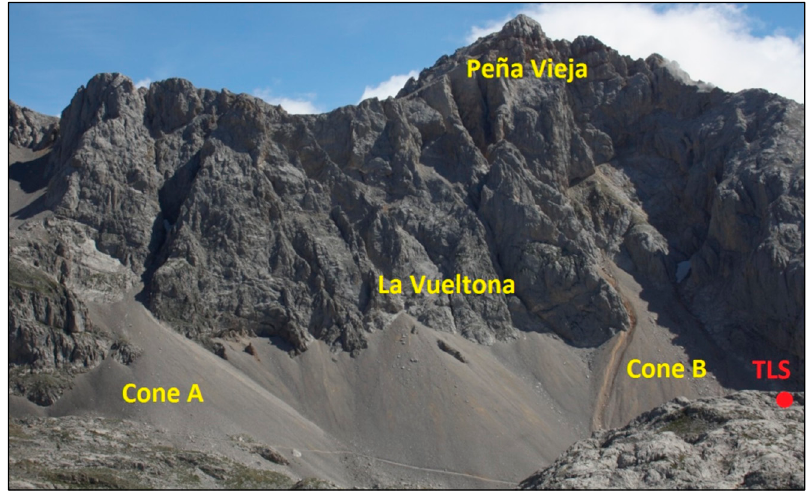
Figure 2. General view of the debris cones of La Vueltona in Peña Vieja Group (Picos de Europa Massif).